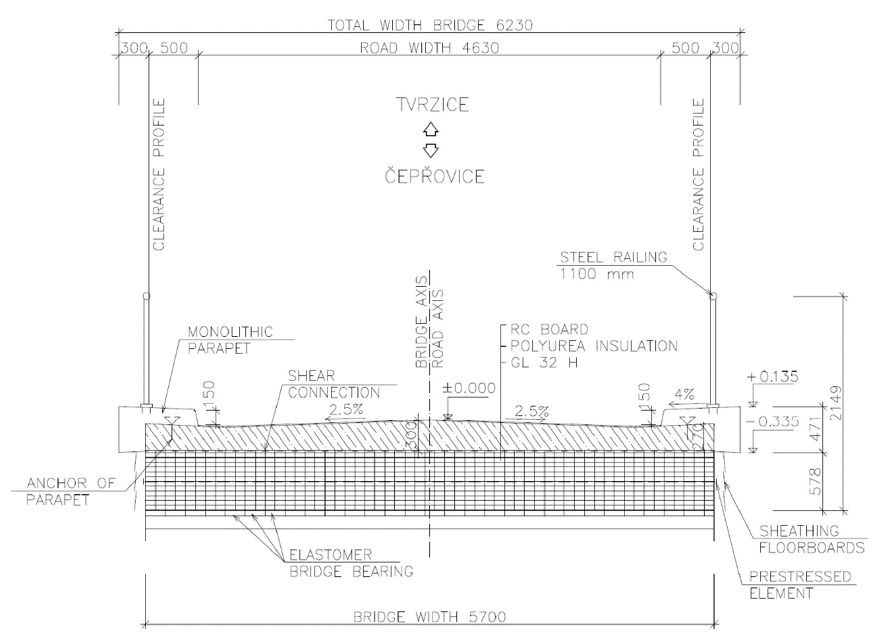
Figure 2. Transverse section of WCB bridge (scale 1:50).